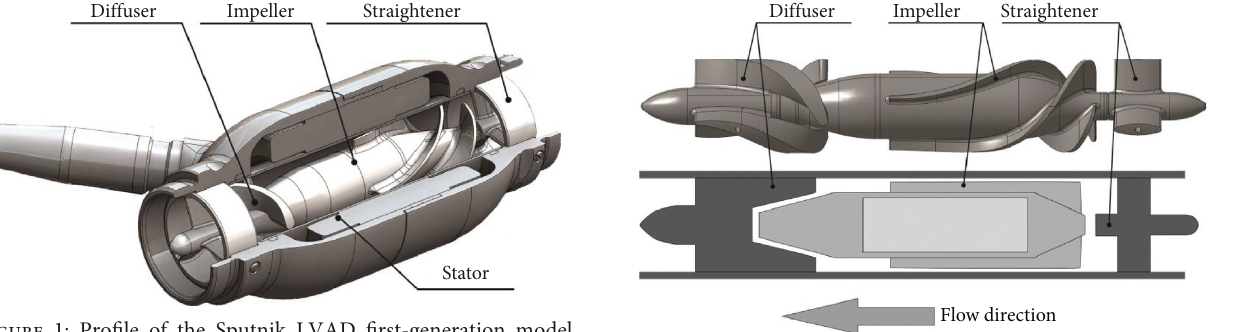
Figure 2: Schematic (bottom) and geometry (top) of the hydraulic part of the Sputnik PRBP.